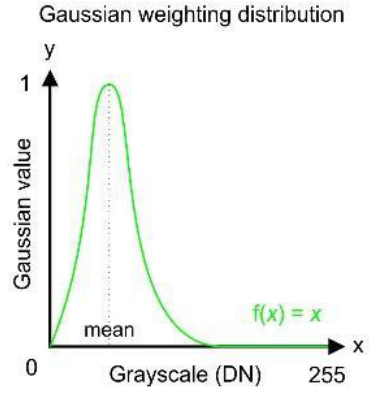
Figure 2 . Proposed Gaussian weighting